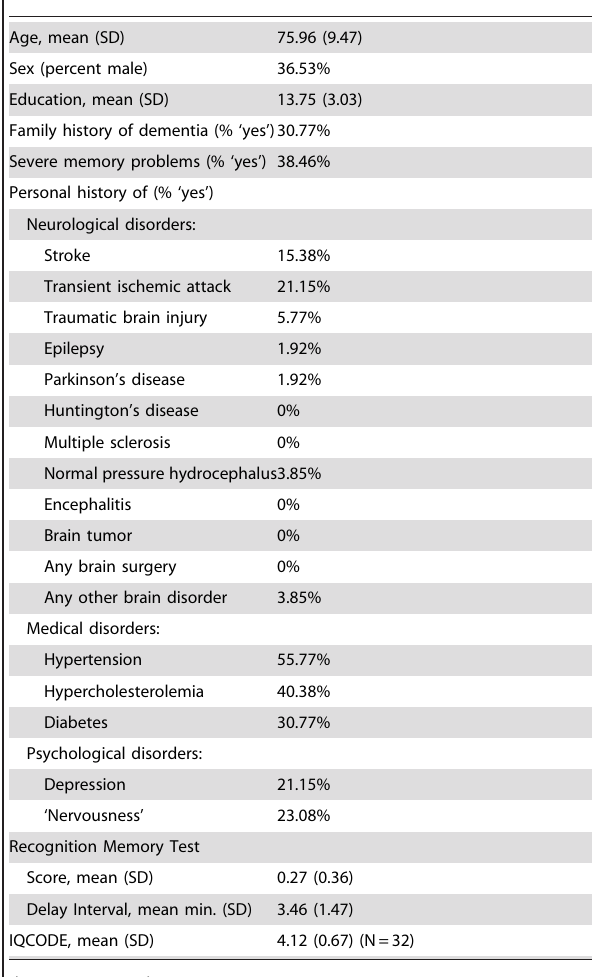
Table 3. Characteristics of 52 outpatients in Clinical Validation Sample who completed the self-report (‘patient page’) of the Dementia Risk Assessment.